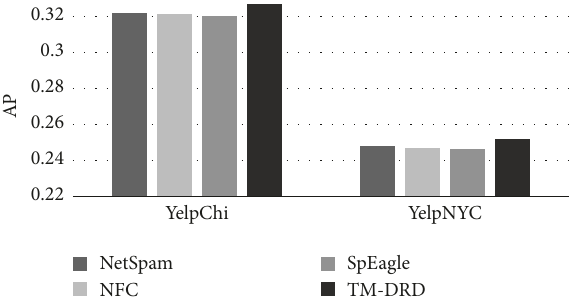
Figure 5: The AP for TM-DRD and SpEagle, NFC, and NetSpam in different datasets.